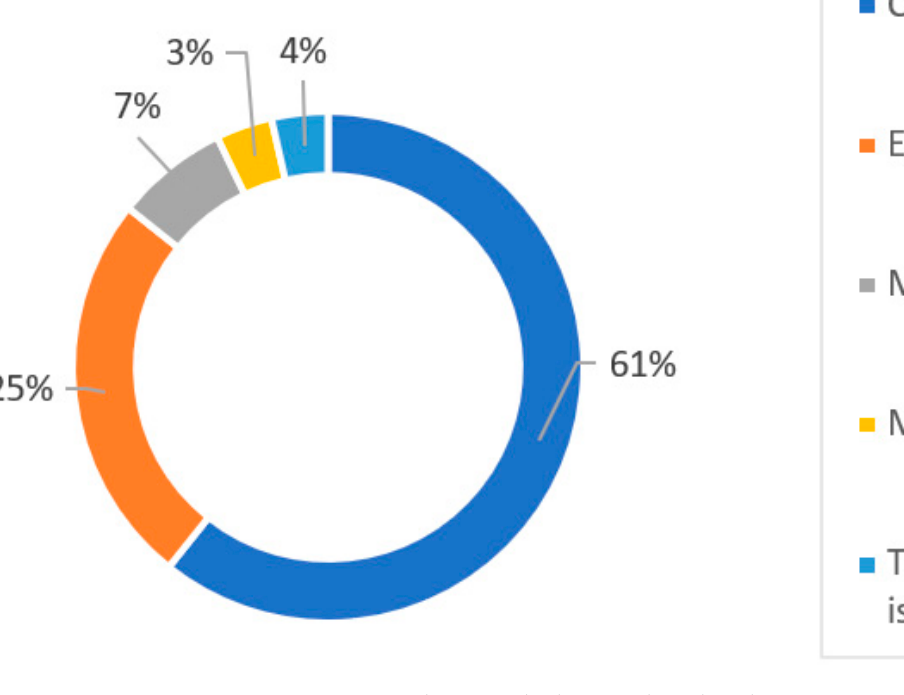
Figure 3. EV isolation methods in preclinical studies.